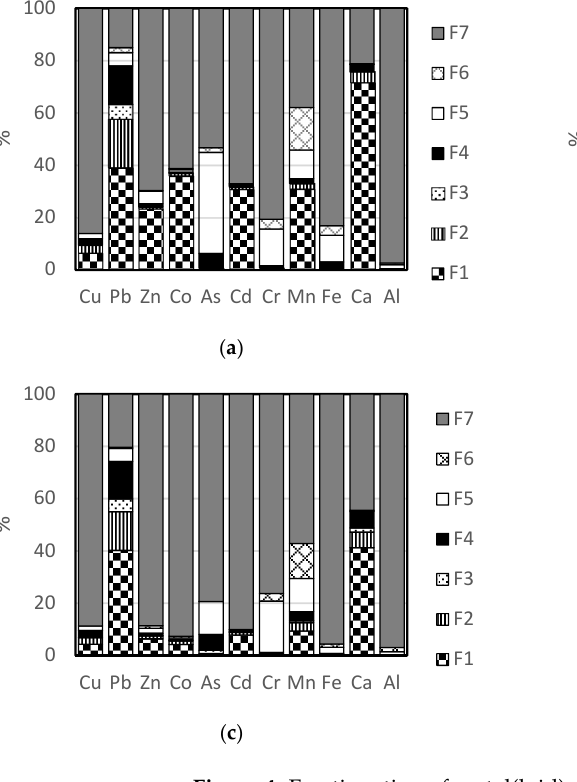
Figure 4. Fractionation of metal(loid)s in: ( a ) Freiberg tailing (FR_01); ( b ) Neves Corvo waste rock (NC_01); ( c ) Neves Corvo tailing (NC_02). F1—mobile fraction, F2—easily deliverable fraction, F3—easily reducible fraction, F4—oxidizable fraction, F5—moderately reducible fraction, F6—poorly reducible fraction, F7—residual bound.